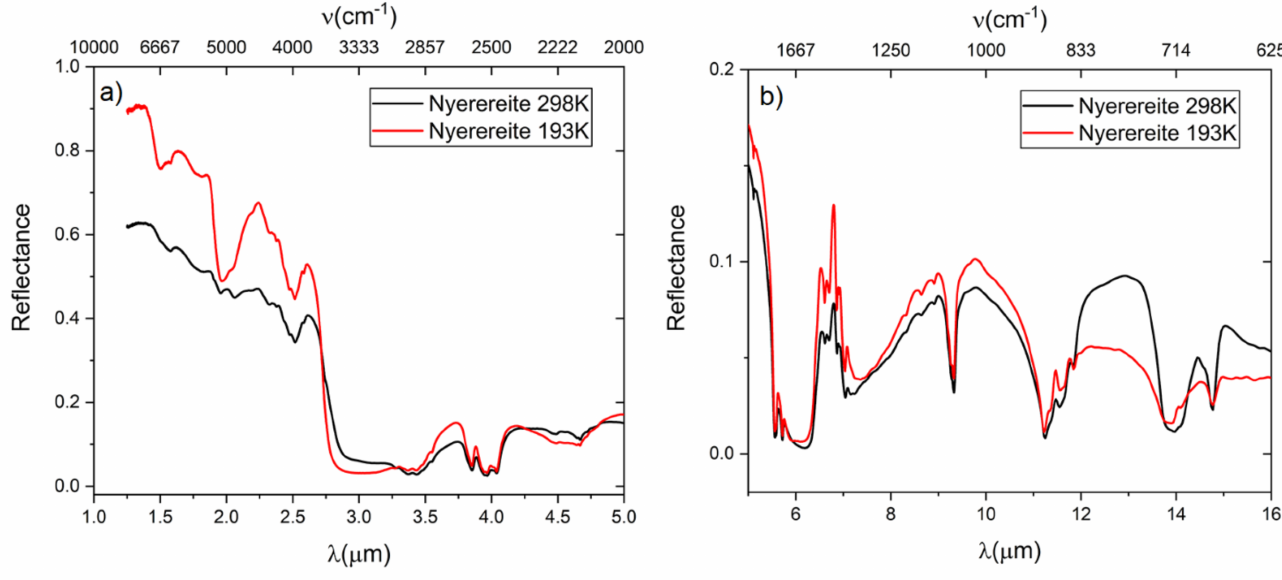
Figure 4. Reflectance spectra at room temperature and 193 K of nyerereite ( a,b